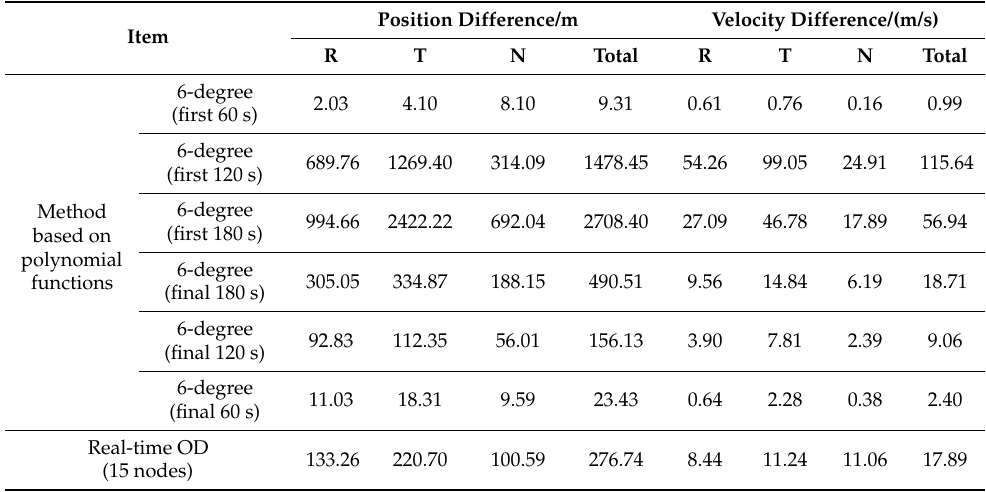
Table 5. Ascent trajectory difference between the method based on polynomial functions and B-spline function with 30 nodes.